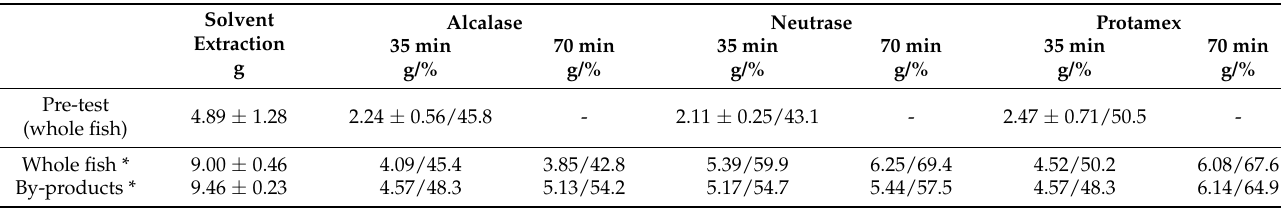
Table 1. Oil yield/recovery from Baltic herring whole fish and by-products from solvent (reference) and enzymatic extractions. The oil yields (g/100 g fw) for pre-tests are presented as mean ± standard deviation and oil recovery as percentage of the solvent-extracted oil. Actual test samples are presented as g/100 g fw and percentage of the solvent- extracted